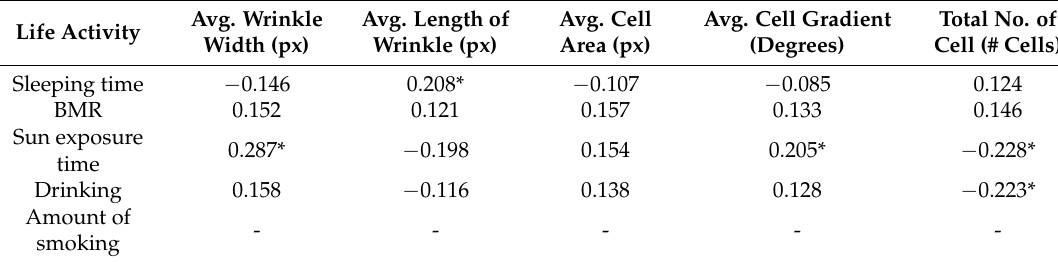
Table 5. Pearson correlation coefficient (subject